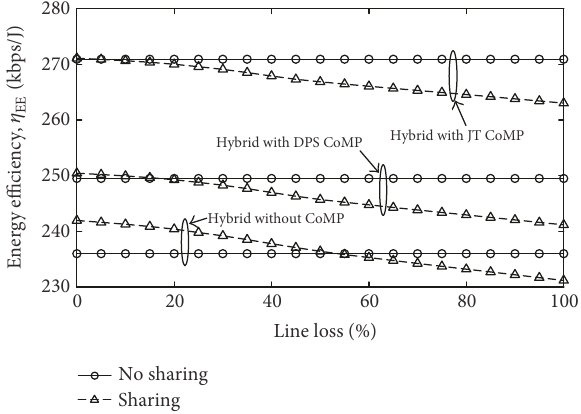
Figure 10: EE variation with line loss under the di ff erent hybrid scenarios with energy sharing considering equal solar